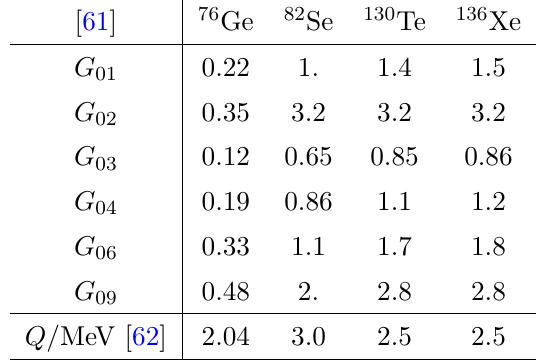
Table 1. Phase space factors in units of 10 − 14 yr − 1 obtained in ref. [61]. The last row shows the Q value of various